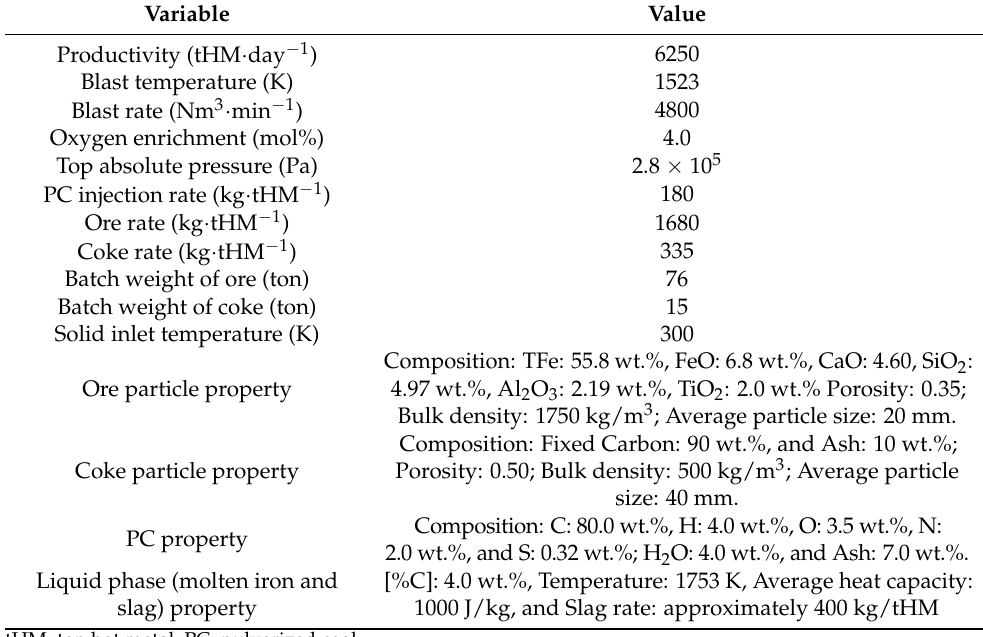
Table 2. BF operation